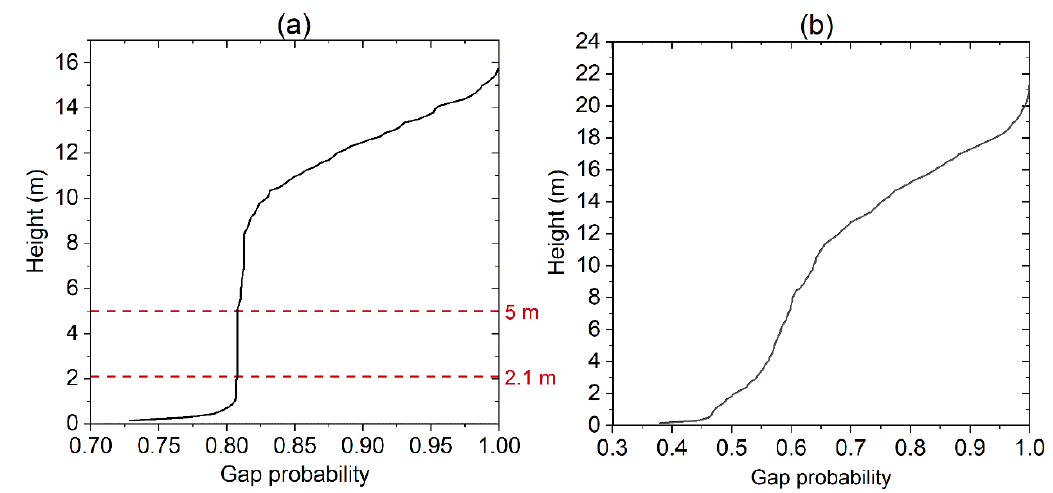
Figure 5. Two patterns of gap probability distribution along the vertical direction: ( a ) with an obvious gap stratum; ( b ) without an obvious gap stratum.